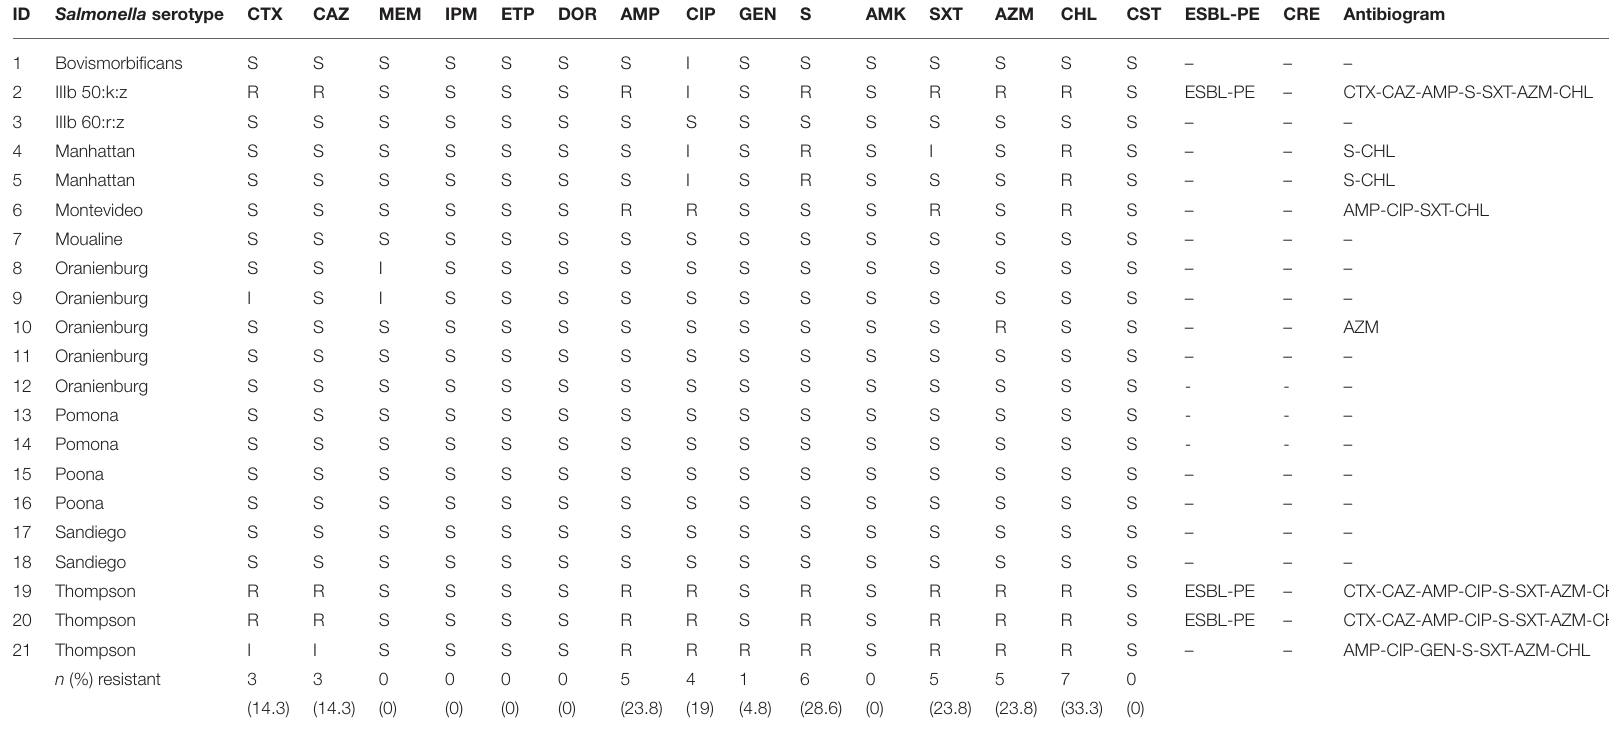
TABLE 3 | Antimicrobial sensitivity of Salmonella enterica isolates against individual antimicrobials using disk diffusion test. ID Salmonella serotype